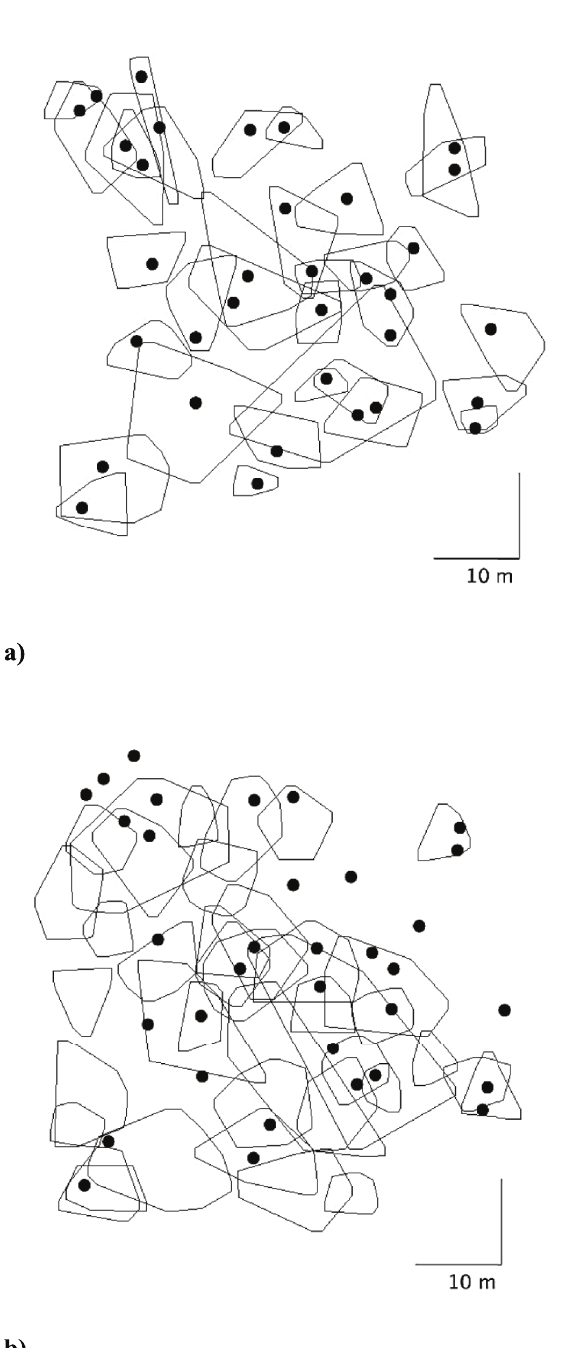
Figure 2. The minimum convex polygon 85% peeled core home ranges for a) adult females with $ 6 sightings (n=32), and b) adult males with $ 10 sightings (n=36), occupying the 50 6 50 m study site. The black points represent female range centers in both cases.